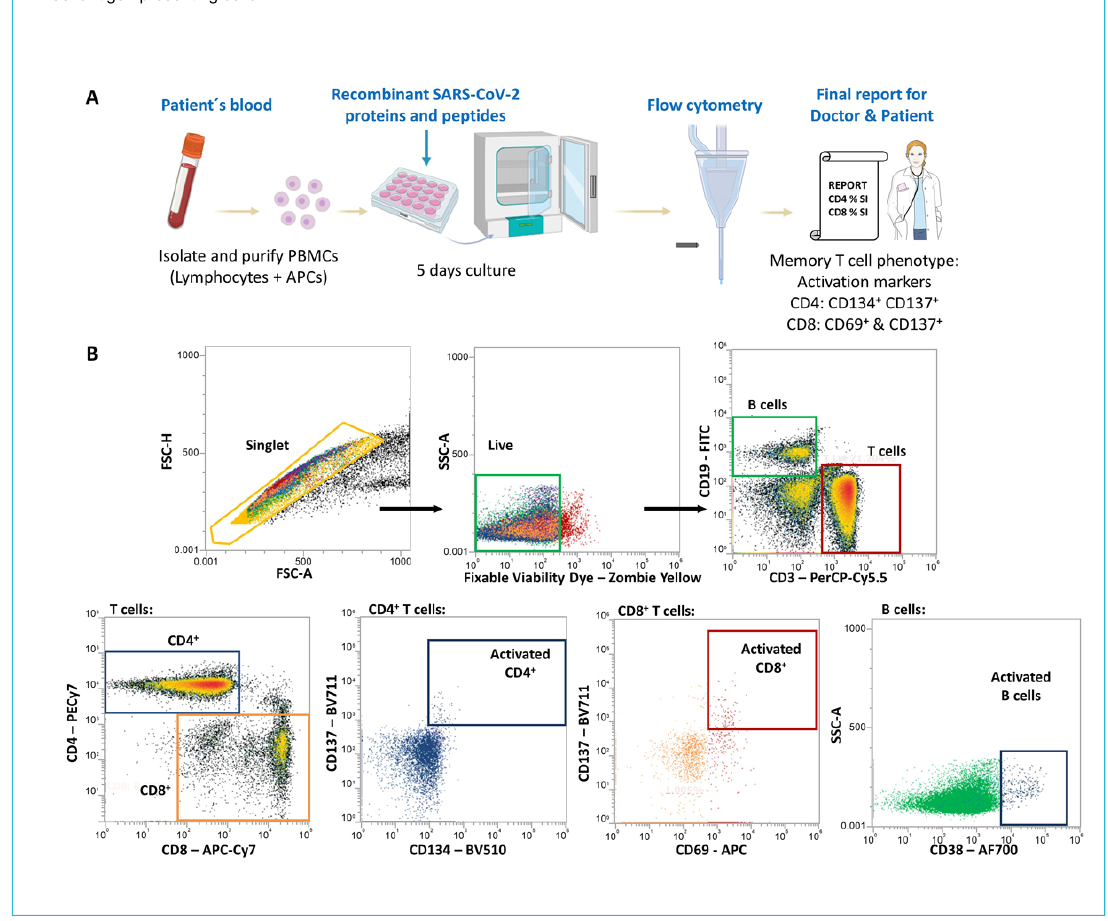
Figure 1: SARS-CoV-2 lymphocyte testing analysis scheme. (A) Flow-chart of the stages involved for the SARS-CoV-2 lymphocyte testing analysis from isolation of the patient´s peripheral blood mononuclear cells (PBMCs) to culturing conditions and flow cytometric analysis before the final report is sent to doctors and patients. (B) Flow cytometry gating strategy to identify activated T and B cells against SARS-CoV-2. APCs: antigen presenting